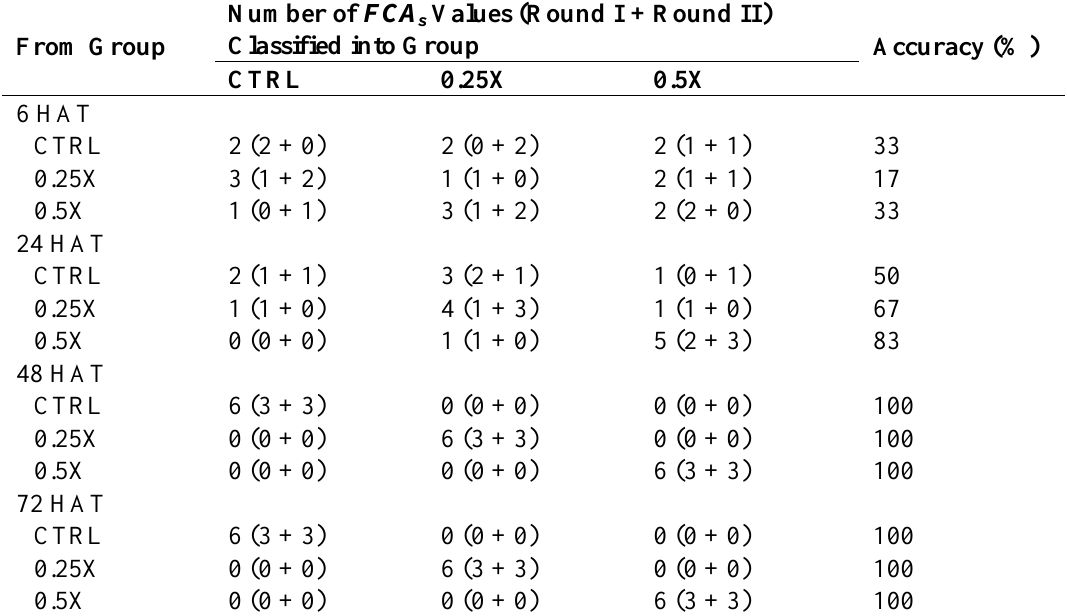
Table 10. Linear discriminant analysis with a two-fold cross validation schema for FCA values of soybean leaves.